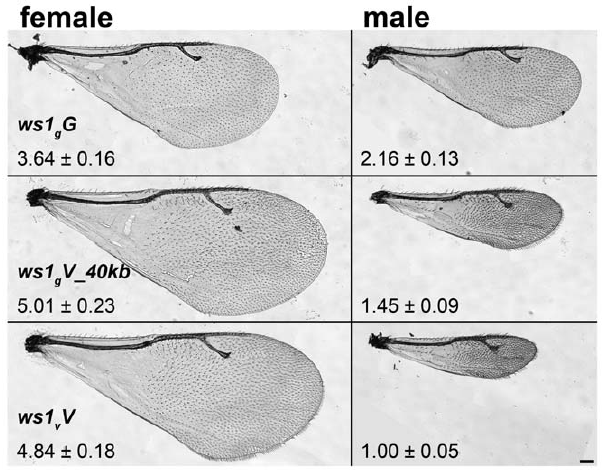
Figure 1. Wing size differences due to ws1. Wings of N. giraulti ( ws1 g G ), N. vitripennis ( ws1 v V ) and giraulti ws1 in vitripennis background ( ws1 g V_40kb ). Wing area 6 S.D. relative to ws1 v V males is shown (see also Table 1). Scale bar: 100 m